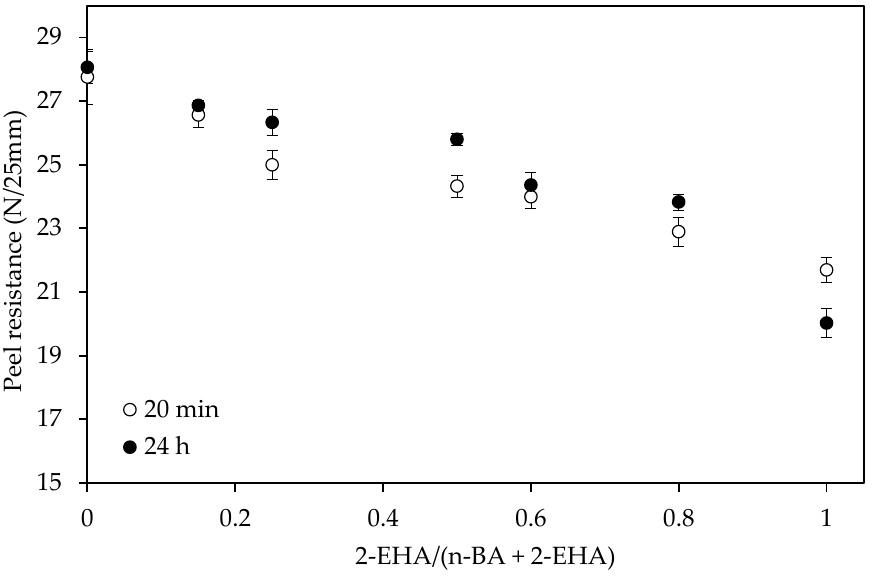
Figure 10. The effect of co-monomer ratio in the peel test using tapes of paper on glass panels (12 g/m 2 of adhesive).